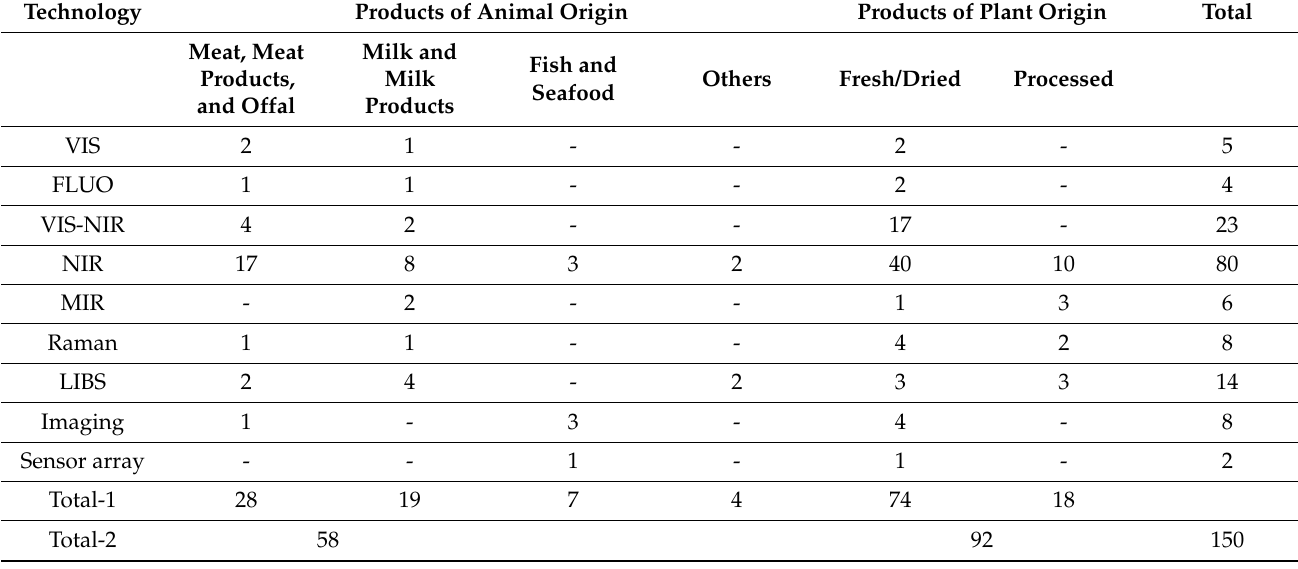
Table 2. Number of studies on handheld applications for food authentication from Supplementary Material—Tables S2–S7 categorised by food product and technology